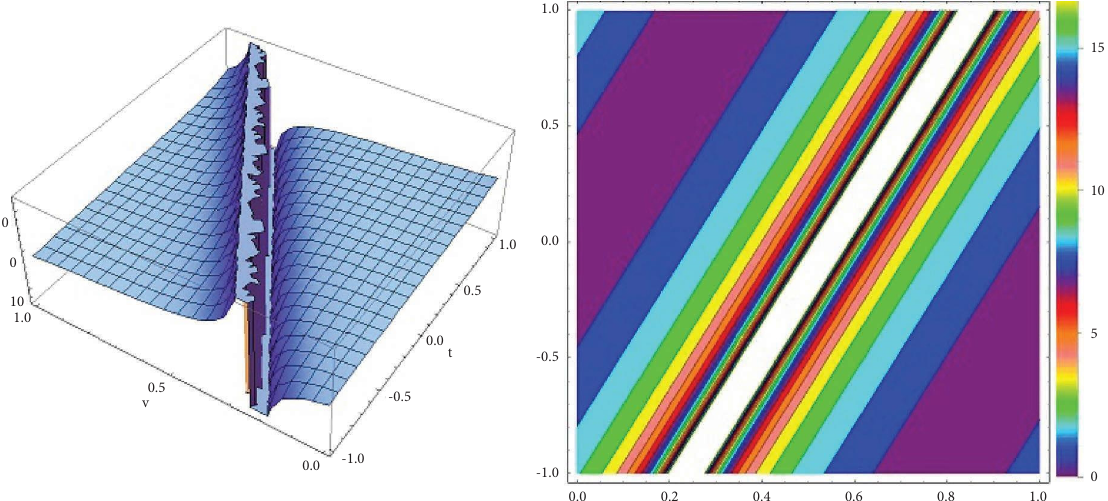
Figure 8: Exact periodic soliton depicted from (34) for ω � 3 . 2.